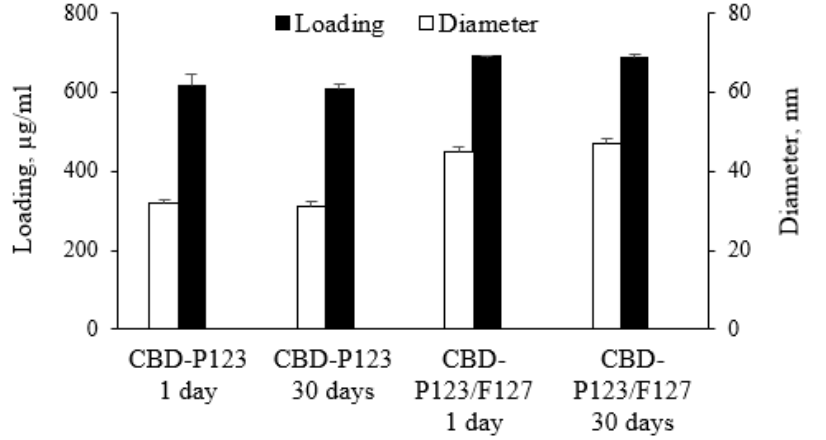
Figure 4. Stability of micellar formulations regarding the mean diameter of micelles and drug loading.